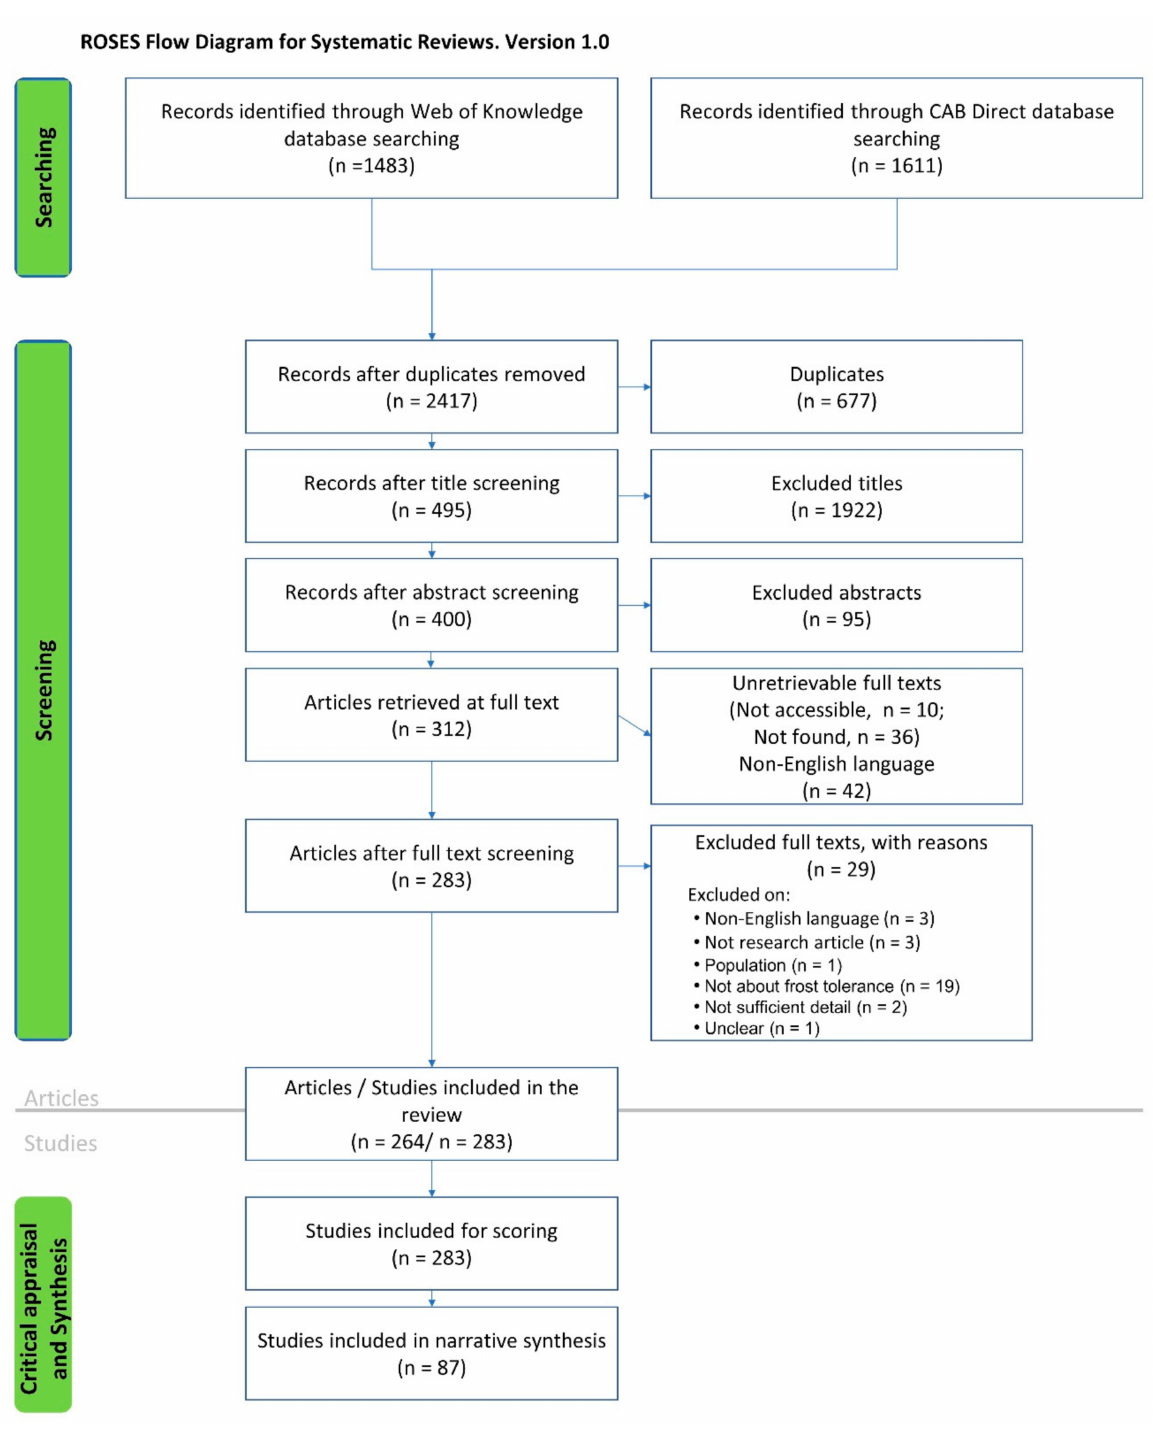
Figure 1. ROSES diagram outlining the search, screening and critical appraisal stages. Adapted from Haddaway et al., (2018) CC by 4.0 2018